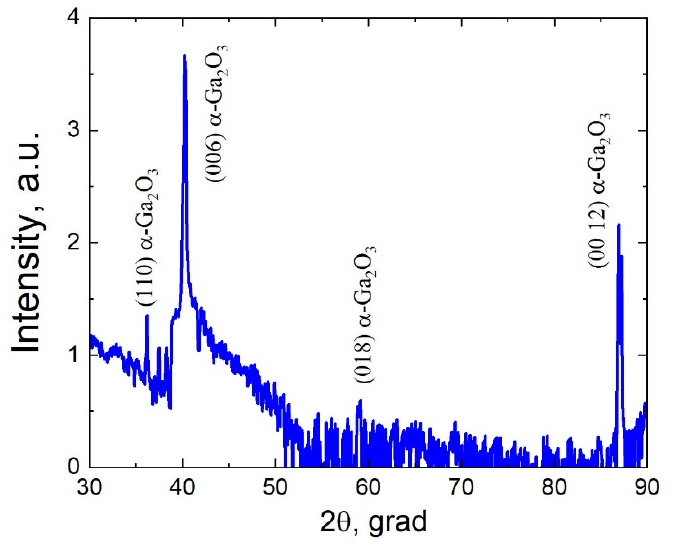
Figure 13. XRD spectrum of an 𝛼 -Ga 2 O 3 sample grown on the 3C-SiC(111)/Si(111) hybrid substrate at 510 °C.